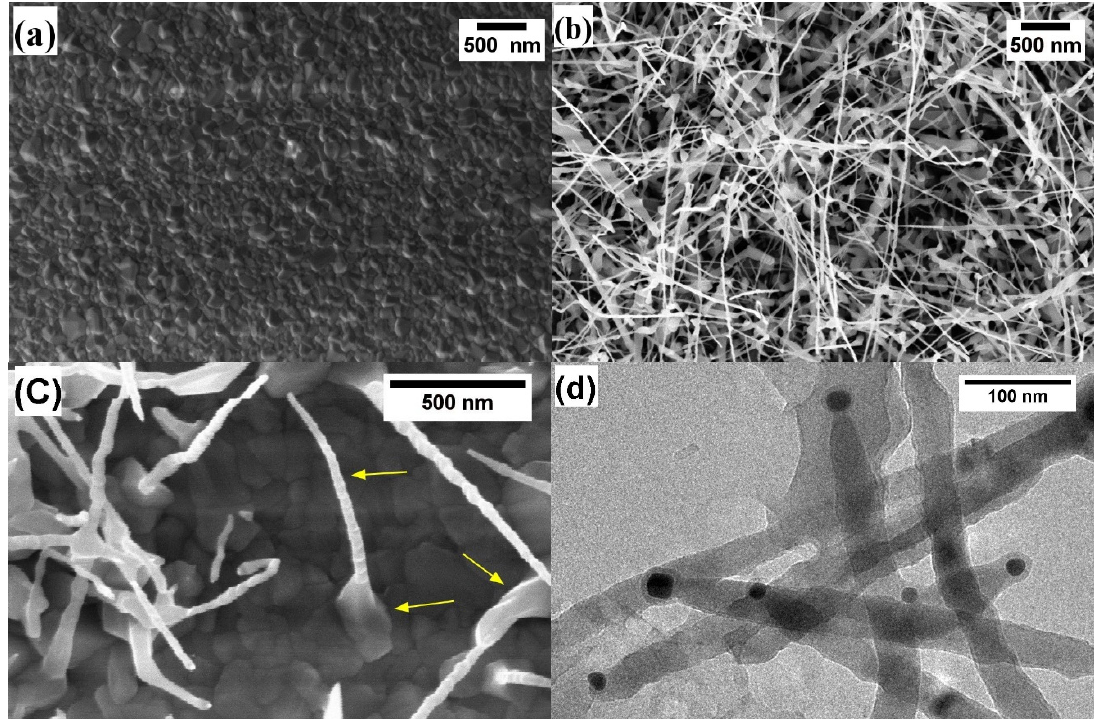
Figure 2. SEM plain views of TiO 2 nanowires (NWs) growth at 700 °C with 10 SCCM oxygen and 100 SCCM argon flow for 3 h, ( a ) without gold catalyst and ( b ) with gold catalyst. ( c ) TiO 2 NWs with narrow needle-like top and wide grains at the bottom. ( d ) TEM image of the TiO 2 nanowires.